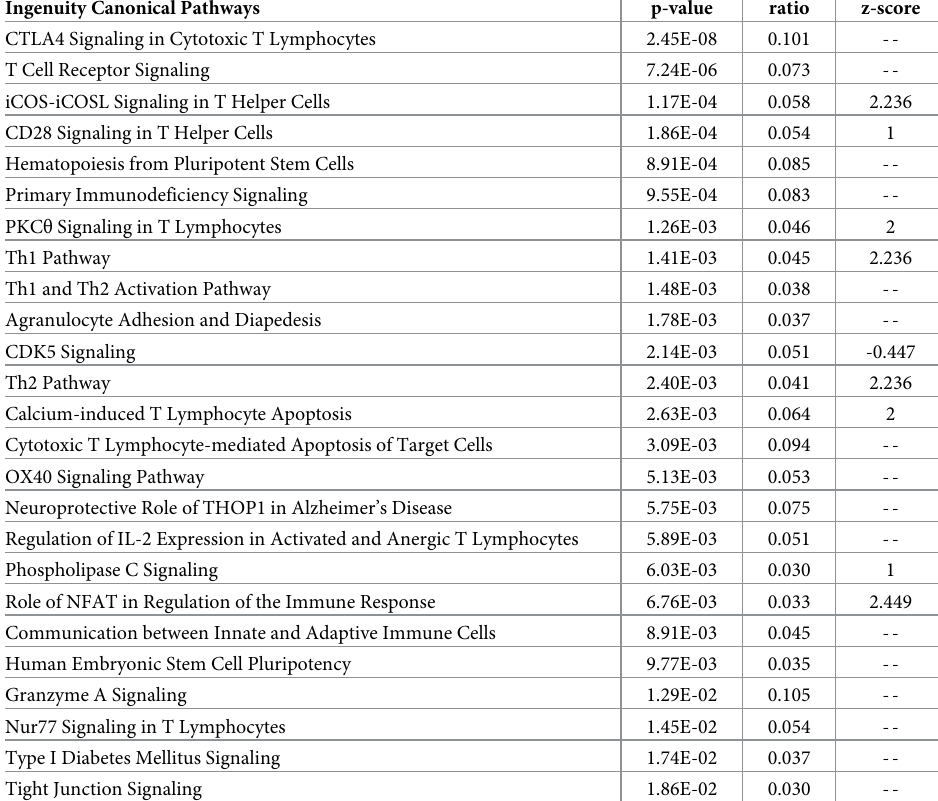
Table 1. Top 25 altered pathways as determined by RNA-sequencing IPA analysis. Ingenuity Canonical